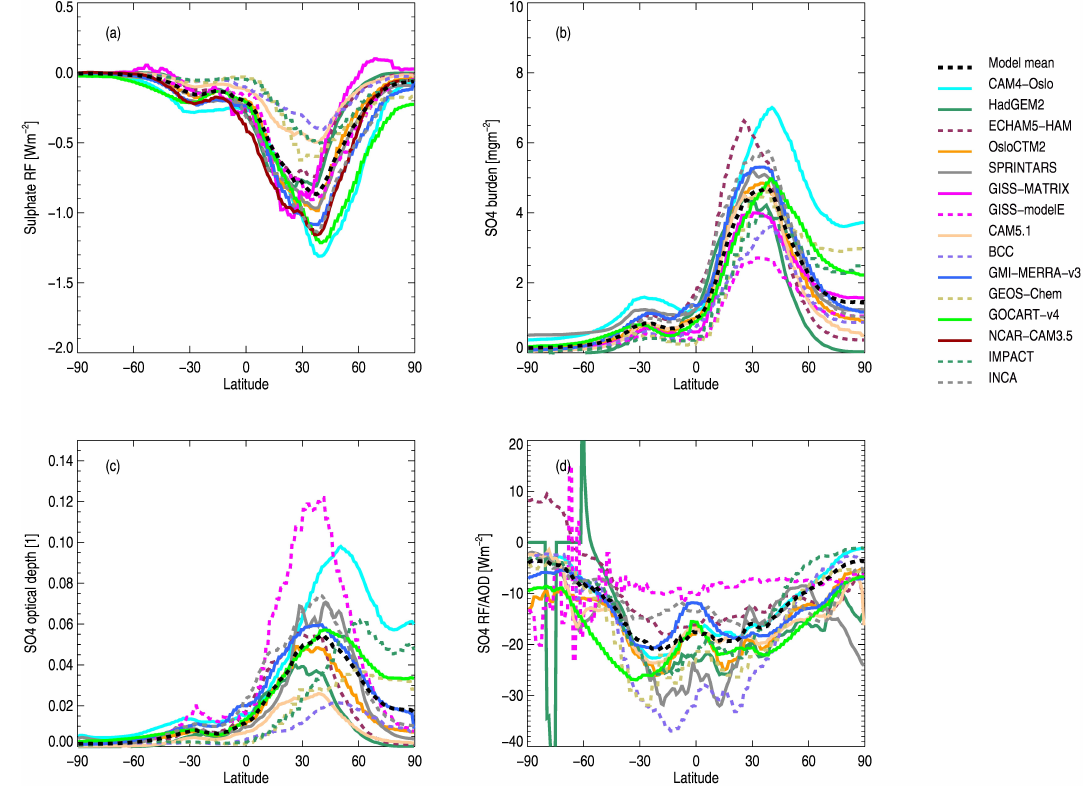
Fig. 8. Zonal mean SO 4 RF (a) , burden (b) , AOD at 550nm (c) , normalized RF with respect to AOD (NRF(A)) (d) .